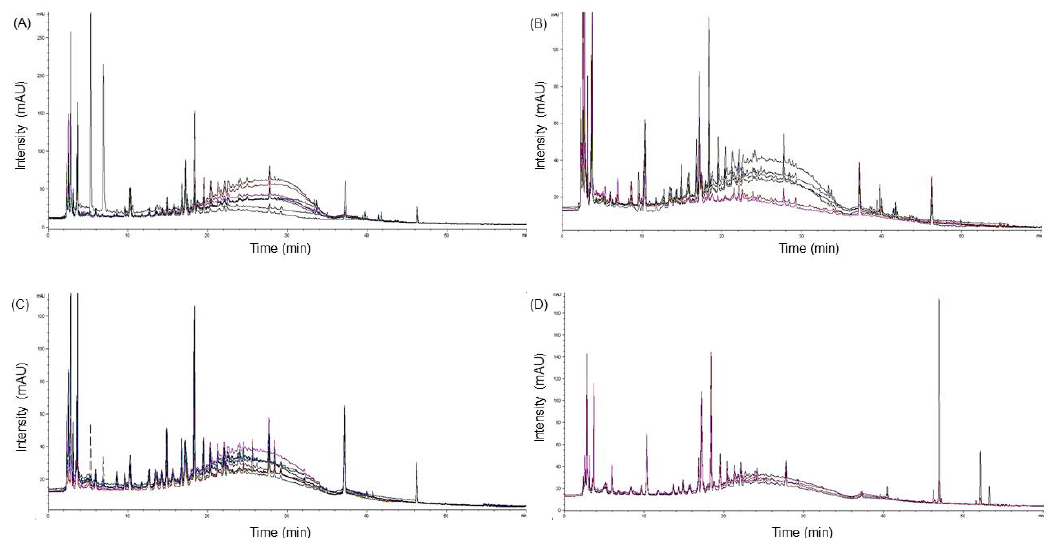
Figure 2. Overlapped chromatograms of the single species of Amomi Fructus samples at 280 nm of detection wavelength (diode array detector (DAD)). A , Amomum villosum samples (AVS01–08); B ,